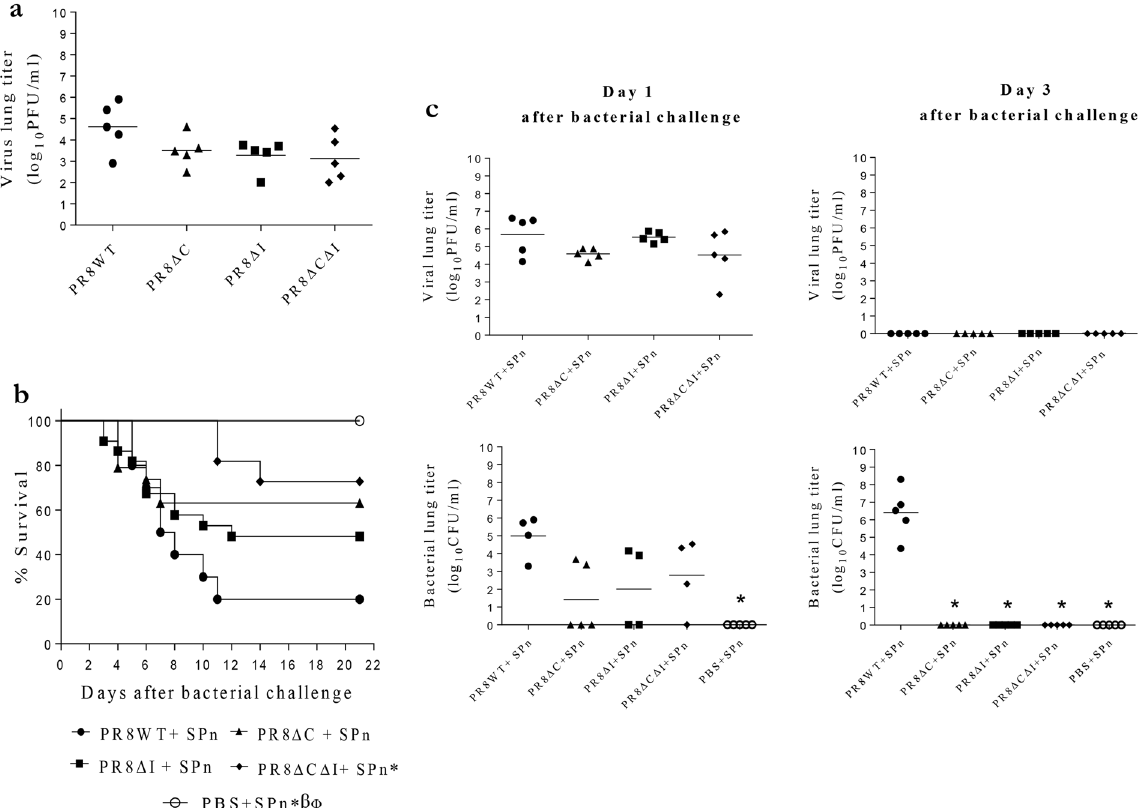
Figure 5. Virulence of H1N1 PB1-F2 mutant viruses in mice. BALB/c mice were intranasally infected with PR8 viruses at a sublethal dose of 15 PFU per mouse ( a – d ), and challenged 7 days later with a sublethal dose of 100 CFU of SPn per mouse or PBS ( b – d ). Virus titers in the mouse lungs (n = 5 each group) at 8 days p.i. ( a ) Survival of mice (n = 10 each group except for the PR8 ∆ C and PR8 ∆ I viruses, for which 19 and 22 mice were used, respectively) after bacterial challenge ( b ). Mouse lungs (n = 4–5 per group; number for each group is indicated in the figure) were collected 1 and 3 days after bacterial challenge and titrated for viral ( c ) and bacterial ( d ) loads. ANOVA followed by t-test ( a , c , and d ) and a log-rank pairwise survival test ( b ) (both with the Bonferroni correction for multiple comparisons) were used to determine the significance of differences. Significant differences (p ≤ 0.05) compared with the WT ( * ), the Δ I ( β ), and the ∆ C ( Φ ). (C and D “Day 3 after bacterial challenge”) The ∆ C data have been previously published (ref. 31 ). PR8WT – virus without